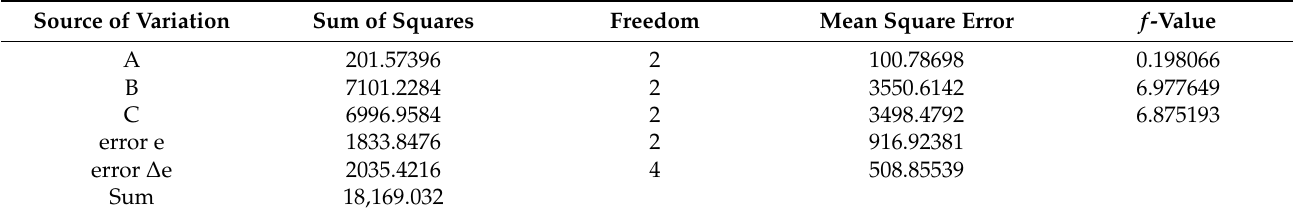
Table 6. The F -values of the ultimate compressive strength of the cube specimens at 28 d.